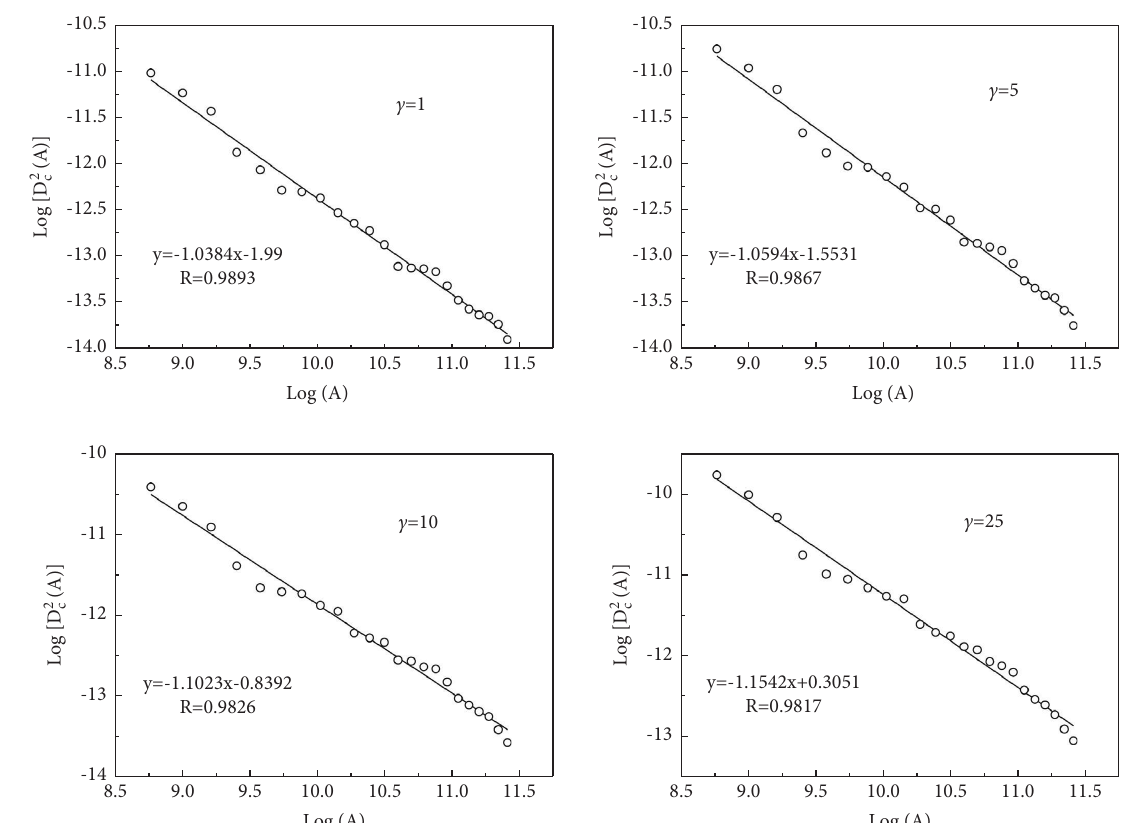
Figure 10: Parameter ftting results for diferent c values ( k � 0 .